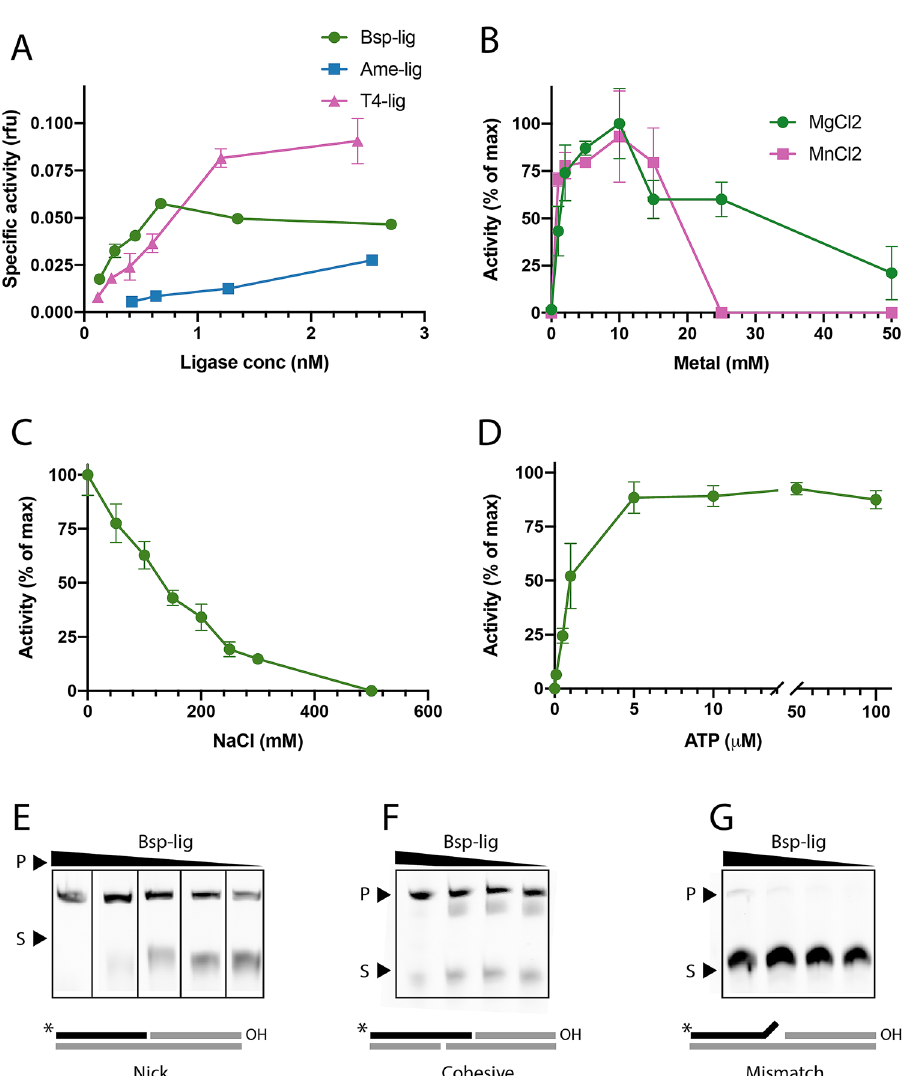
Figure 3. DNA ligase activity of Bsp-lig. Measured by molecular beacon assay ( A - D ) or urea-PAGE ( E – G ). ( A ) Specific activity of Bsp-lig (green circle) relative to Ame-lig (blue square) and T4 DNA ligase (purple triangle). ( B ) Relative activity of Bsp-lig with MgCl 2 as the divalent cation (green circle) or MnCl 2 (purple square). ( C ) Effect of NaCl on Bsp-lig activity). ( D ) Effect of ATP concentration on Bsp-Lig activity. ( E ) Bsp-lig activity with nicked substrate (Bsp-lig concentrations 20 nM, 10 nM, 5.0 nM, 2.5 nM, 1.8 nM). ( F ) Bsp-lig activity with cohesive-end substrate (Bsp-lig concentrations 550 nM, 55 nM, 20 nM, 10 nM). ( G ) Bsp-lig activity